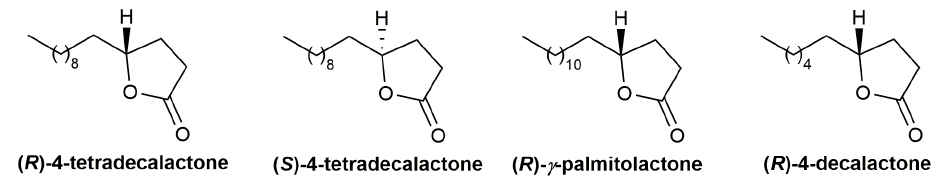
Figure 11. Structure of some naturally occurring γ -alkyl-substituted γ -butyrolactones.